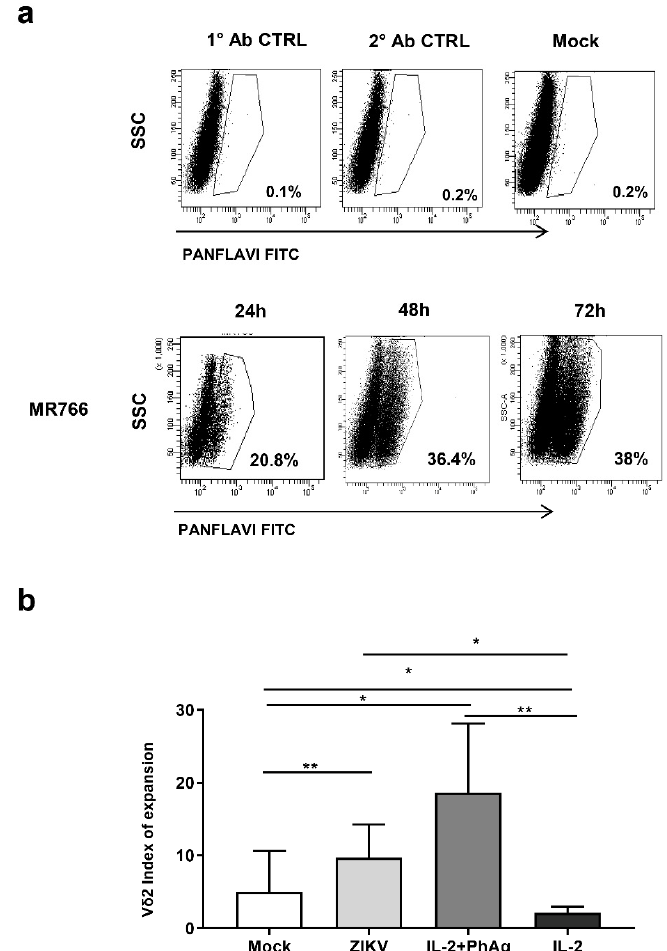
Figure 1. ( a ) Zika virus (ZIKV) infects A549 cells and elicits expansion of V δ 2 T-cells. A549 cells were infected with ZIKV MR766 strain and the frequency of ZIKV + cells was analyzed by flow cytometry using the PANFLAVI antibody after 24, 48, and 72 h. Flow cytometry panels of one representative experiment out of 15 are shown. PANFLAVI + gate was set to include ≤ 0.2% of events when using primary or secondary antibody isotype controls or uninfected cells (mock). ( b ) Expansion index of V δ 2 T-cells in co-culture with ZIKV-infected cells was shown. A549 cells were not infected (mock) or infected with ZIKV MR766 and cultured with peripheral blood mononuclear cells (PBMC) of healthy donors (HD). IL-2 or IL-2 + PhAg were added in parallel cultures as controls. V δ 2 T-cells frequency was calculated at baseline (T0) and after 7 days (T7). The expansion index was calculated by dividing V δ 2 T-cells frequency at 7 days in respect to T0. Results from 13 independent experiments are shown. Data were represented as median + interquartile range. *: p < 0.05; **: p < 0.01.